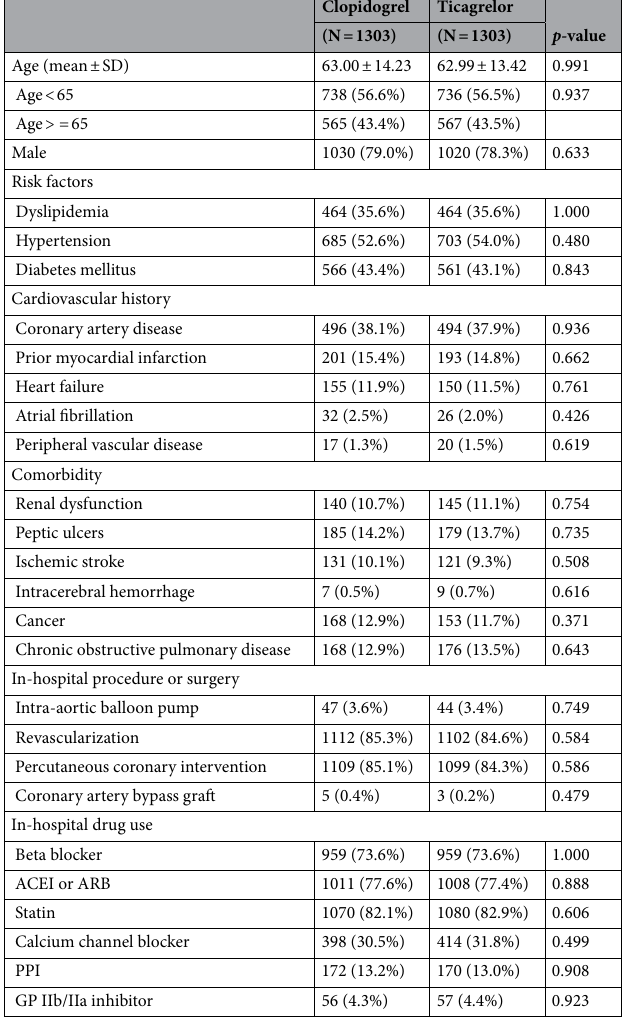
Table 2. Baseline characteristics of subjects with non-ST elevation myocardial infarction after propensity score matching. Data given as mean ± SD or n (%). ACEI angiotensin-converting enzyme inhibitor, ARB angiotensin receptor blocker, GP glycoprotein.